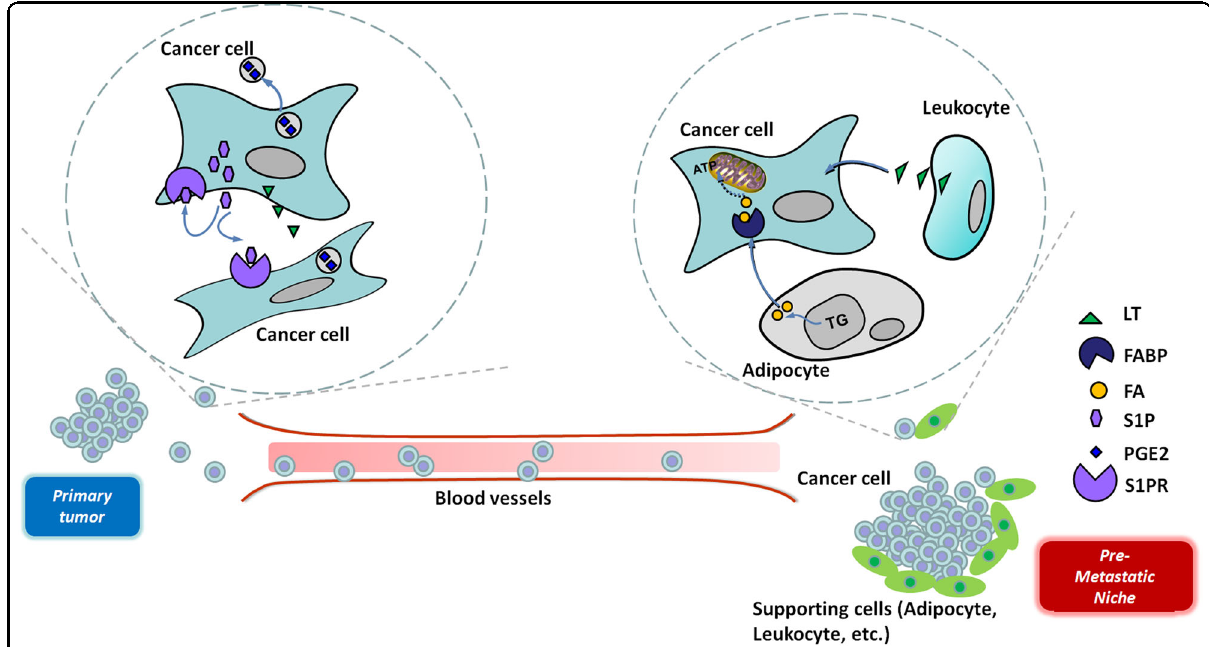
Fig. 3 Illustrations of the signaling lipids implicated in cancer metastasis. Signaling lipids accumulate intracellularly or are secreted extracellularly to facilitate tumor cell aggressive progression and metastasis. CTC circulating tumor cell, FA fatty acid, FABP fatty acid-binding protein, LT leukotriene, PGE2 prostaglandin E2, S1P sphingosine-1-phosphate, S1PR S1P